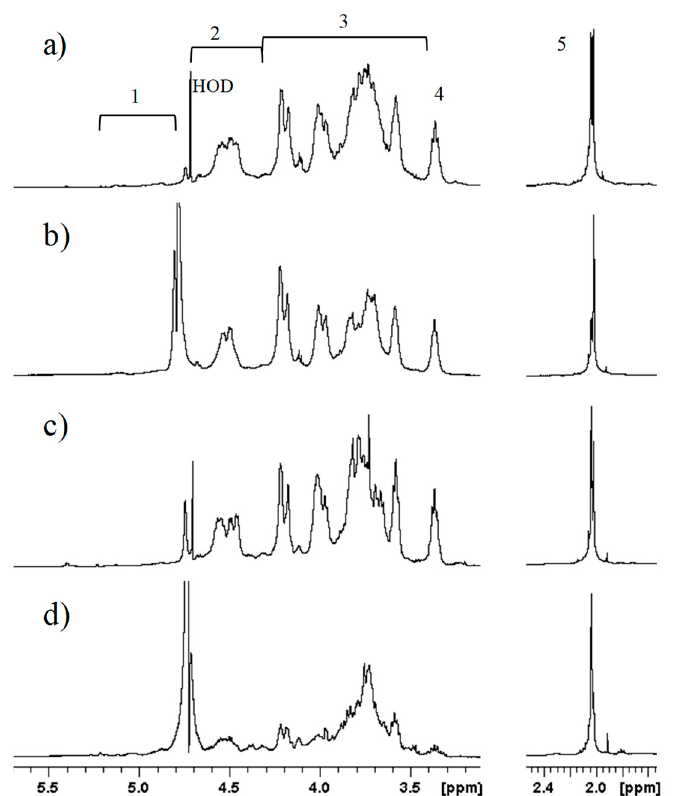
Figure 1. Superimposition of 1 H-NMR spectra of glycosaminoglycan chains (GAGs) isolated from ( a ) chondrosarcomas sample 2 (CS2), ( b ) osteochondromas sample 1 (OC1), ( c ) prepubescent growth plate samole 1 (GRP1), and ( d ) fetal growth plate sample 3 (FT3). The main signal regions are